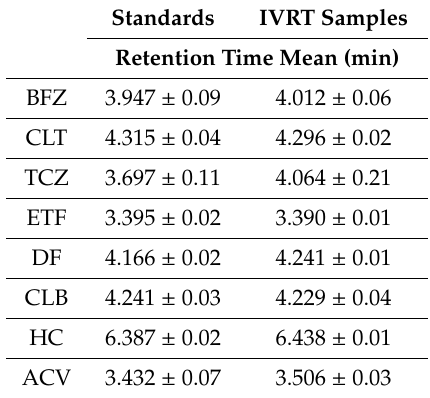
Table 4. Retention times for standards (n = 45) and IVRT samples (n =